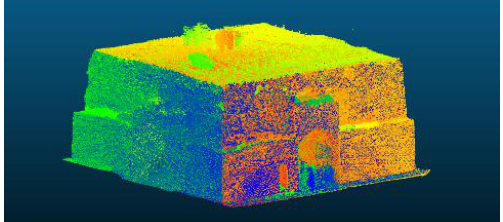
Figure 5. Raw point cloud